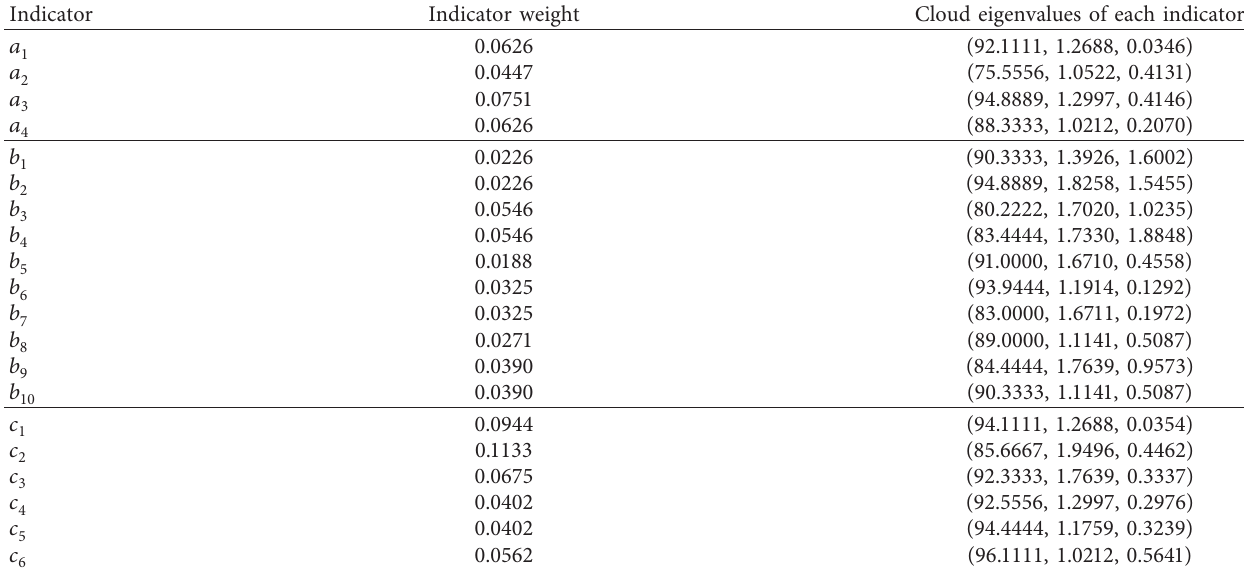
Table 9: Indicator weights and cloud eigenvalues of section